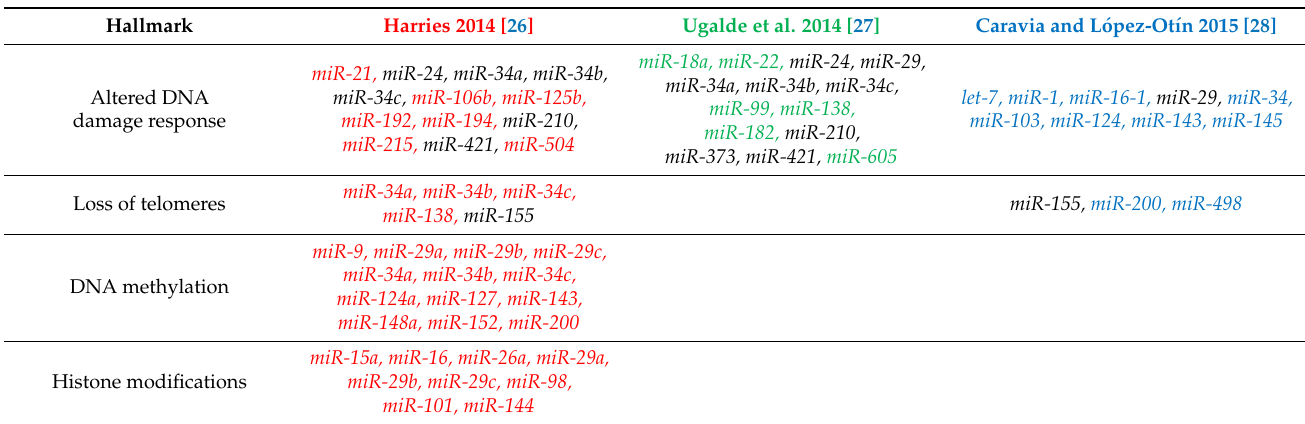
Table 1. Functional classification of geromiRs compiled from three review articles. The colored geromiRs are specific for each